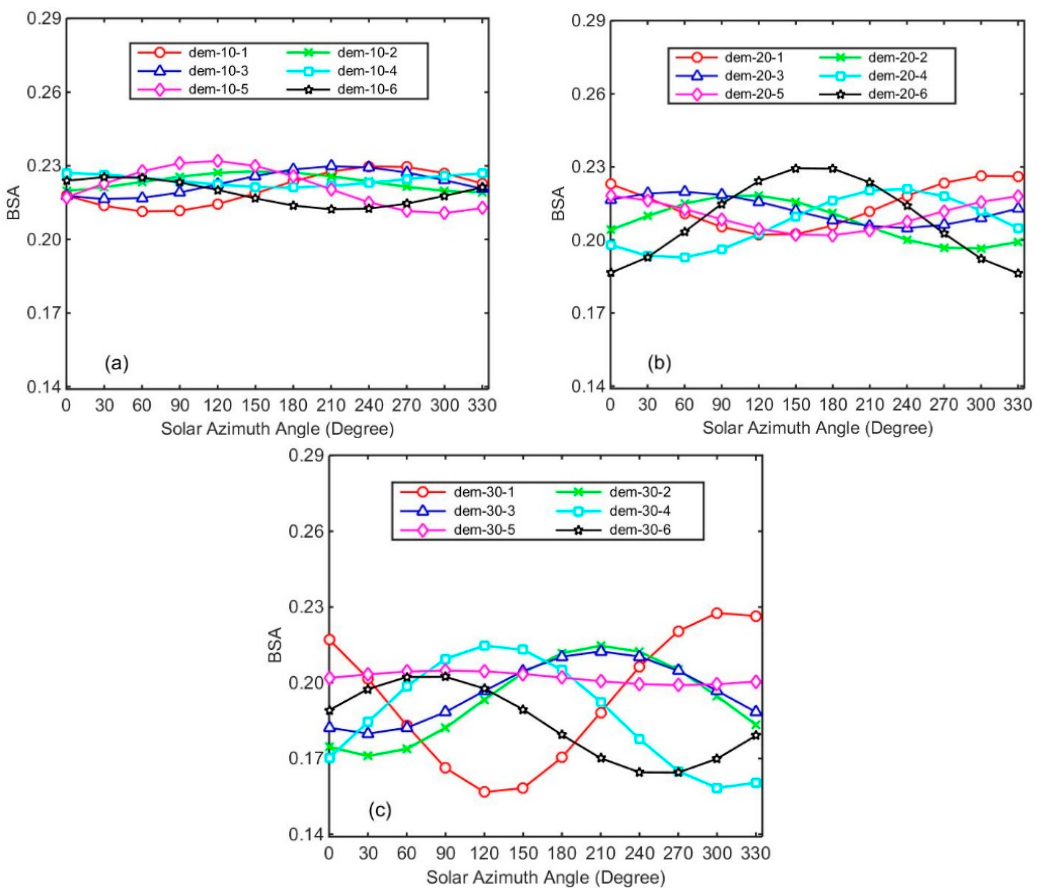
Figure 12. BSA variations with SAA for terrains with different mean slopes: ( a ) 10°; ( b ) 20° and ( c ) 30°. The SZA is 30°.